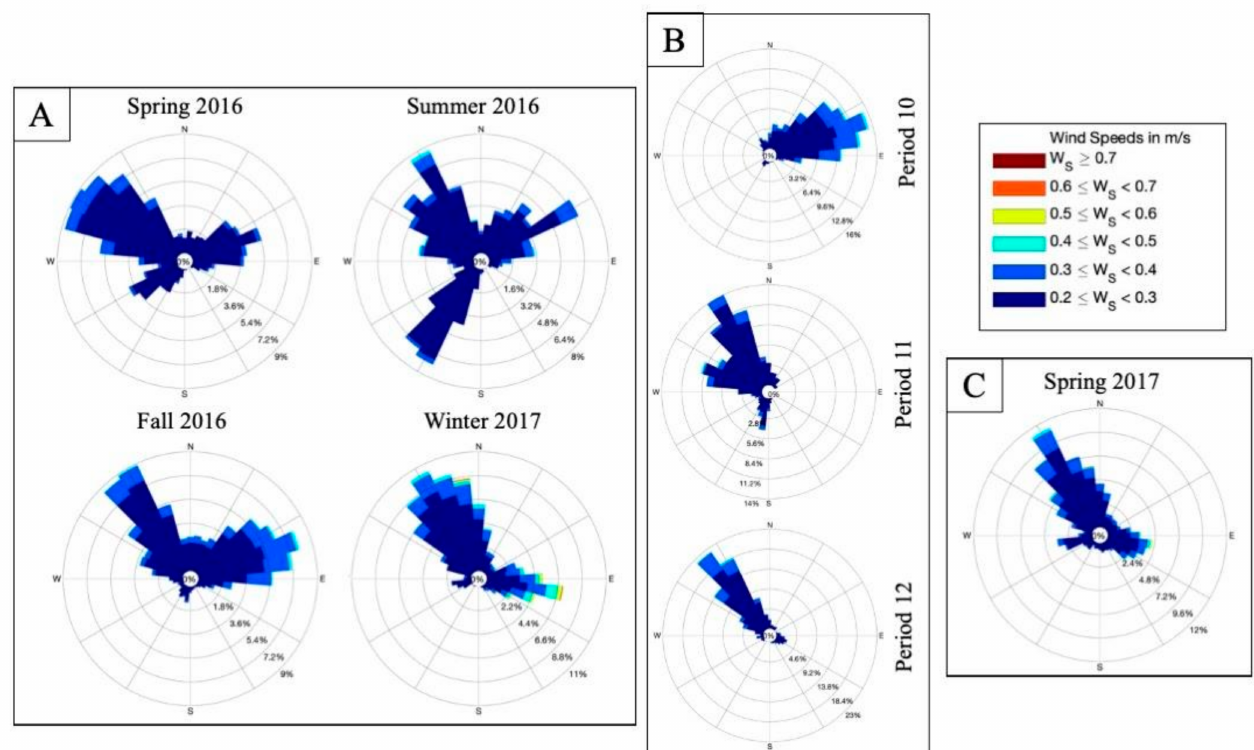
Figure 3. A subset of wind roses showing collection periods, seasonal, and annual wind velocities above the critical threshold of motion for the measured sediment grain size. ( A ) Seasonal wind roses for the 2016–2017 period. ( B ) Three wind roses for the fall of 2016, showing the variability of wind velocity between monthly collections compared to the overall seasonal winds (Fall 2016, plot A). ( C ) Seasonal wind rose for spring 2017 as an annual comparison to spring 2016 (plot A). All plots use the same scale shown in the upper right